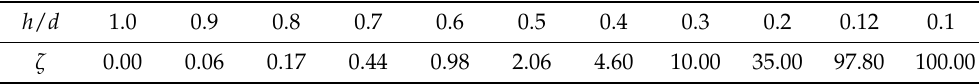
Table 1. ζ -values for different degrees of opening of a sliding valve with diameter d and height h of the